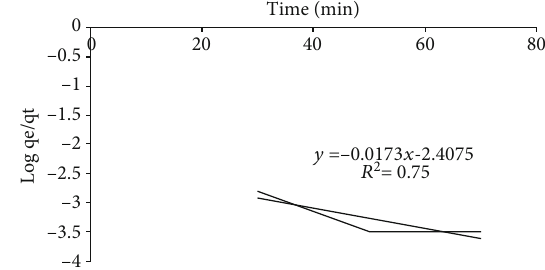
Figure 8: The pseudo fi rst-order kinetic plots for the adsorption of RR2 onto prepared adsorbent.